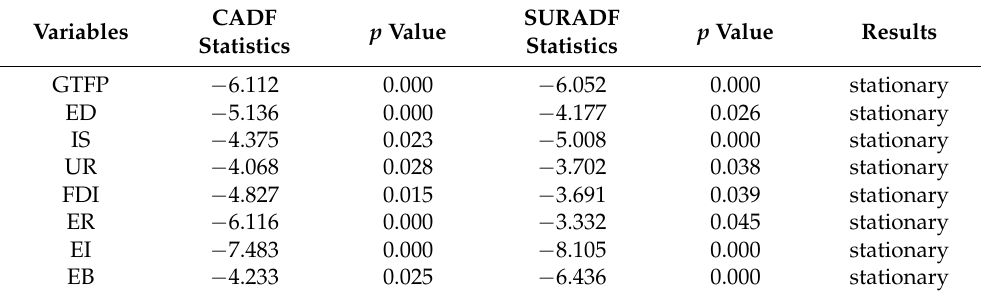
Table 5. Stationarity test of panel data.